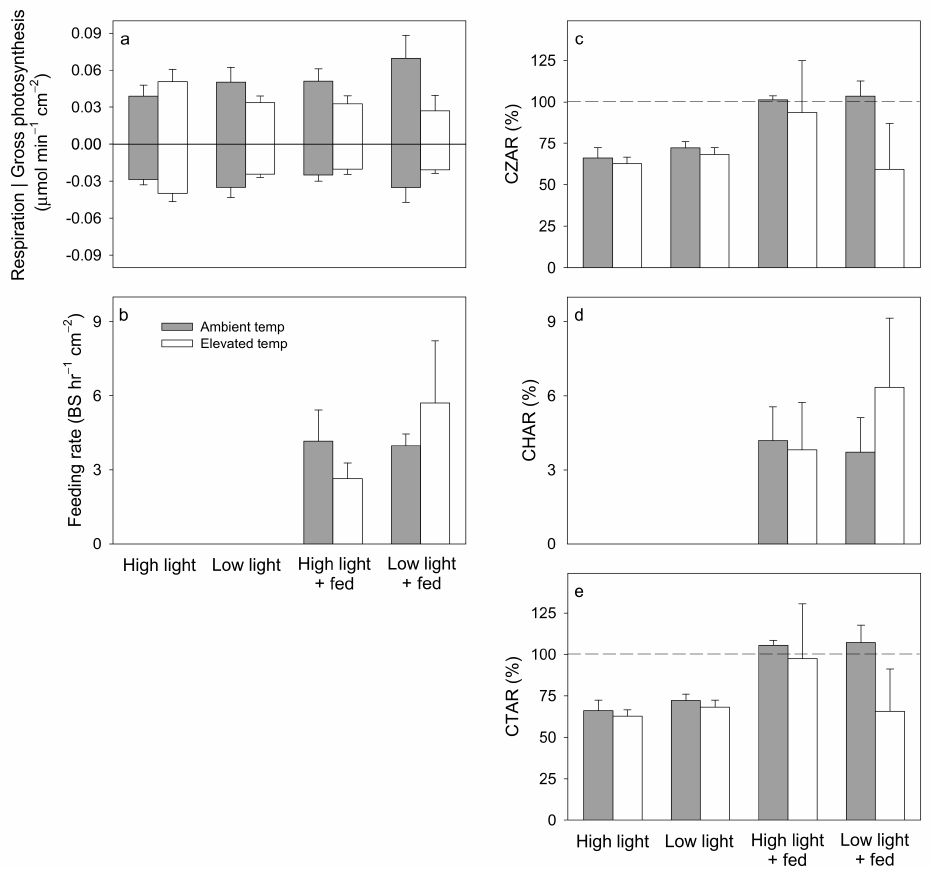
Figure 4. Pocillopora damicornis average ( ± 1 SE) ( a ) photosynthesis and respiration, ( b ) feeding rate, ( c ) Contribution of Zooxanthellae (Symbiodiniaceae) to Animal Respiration (CZAR), ( d ) Contribution of Heterotrophy to Animal Respiration (CHAR) from feeding on Artemia nauplii, and ( e ) Contribution of Total acquired fixed carbon relative to Animal Respiration (CTAR = CZAR + CHAR), under ambient temperature (25 ◦ C, solid bars) and elevated temperature (30 ◦ C, open bars) within high light (300 µ mol photons m − 2 s − 1 , unfed), low light (150 µ mol photons m − 2 s − 1 , unfed), high light + fed (300 µ mol photons m − 2 s − 1 , fed), and low light + fed (150 µ mol photons m − 2 s − 1 , fed) treatments. N = 3 for all averages. Significant effects from corresponding ANOVAs in Table